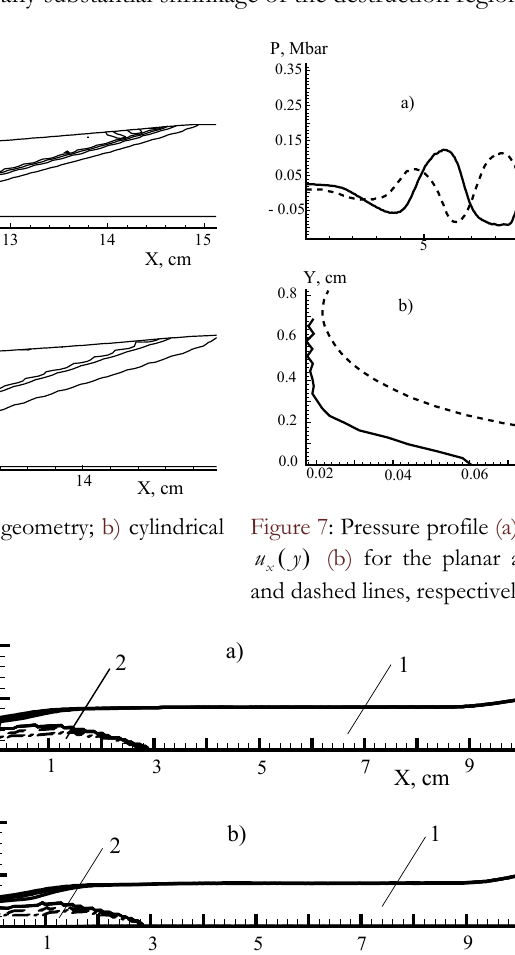
m across the sample. The solid and 1